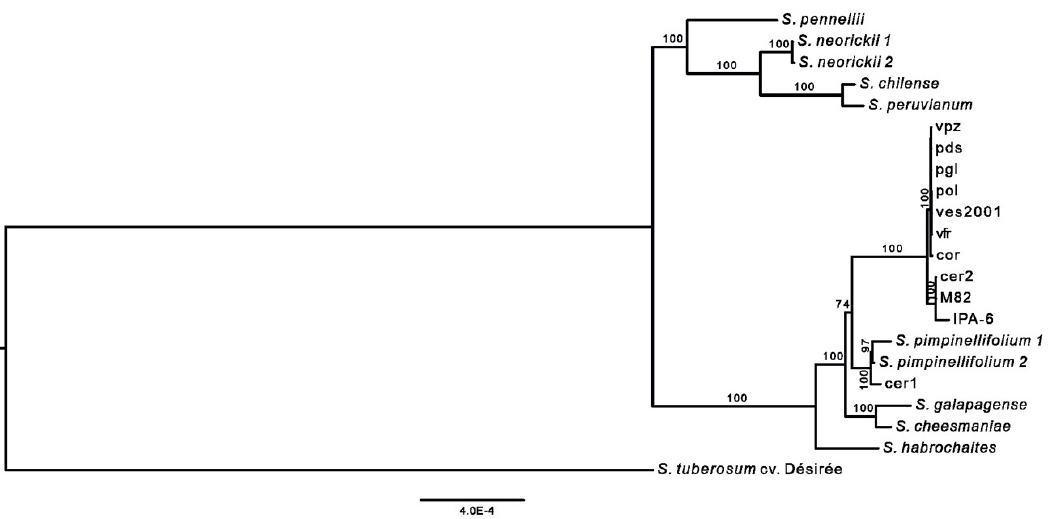
Figure 5. Phylogenetic tree of cultivated and wild tomato genotypes. Phylogram of the best maximum-likelihood (ML) tree on the complete plastome dataset using Solanum tuberosum cv. Désirée (DQ386163) as the outgroup. Numbers associated with branches are ML bootstrap support values. Bootstraps higher than 70% are reported on the nodes.